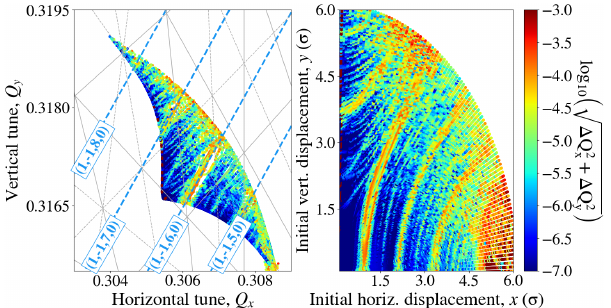
FIG. 4. Frequency map analysis (left) and initial configuration space (right) including synchrotron oscillations with chromaticity Q 0 ¼ 5 in both transverse planes, relative momentum deviation δ p=p ¼ 27 × 10 − 5 , modulation depth Δ Q ¼ 1 . 35 × 10 − 3 and modulation index β m ¼ 0 . 64 . The blue lines depict the sidebands ( m ≤ 8 ) of the linear coupling